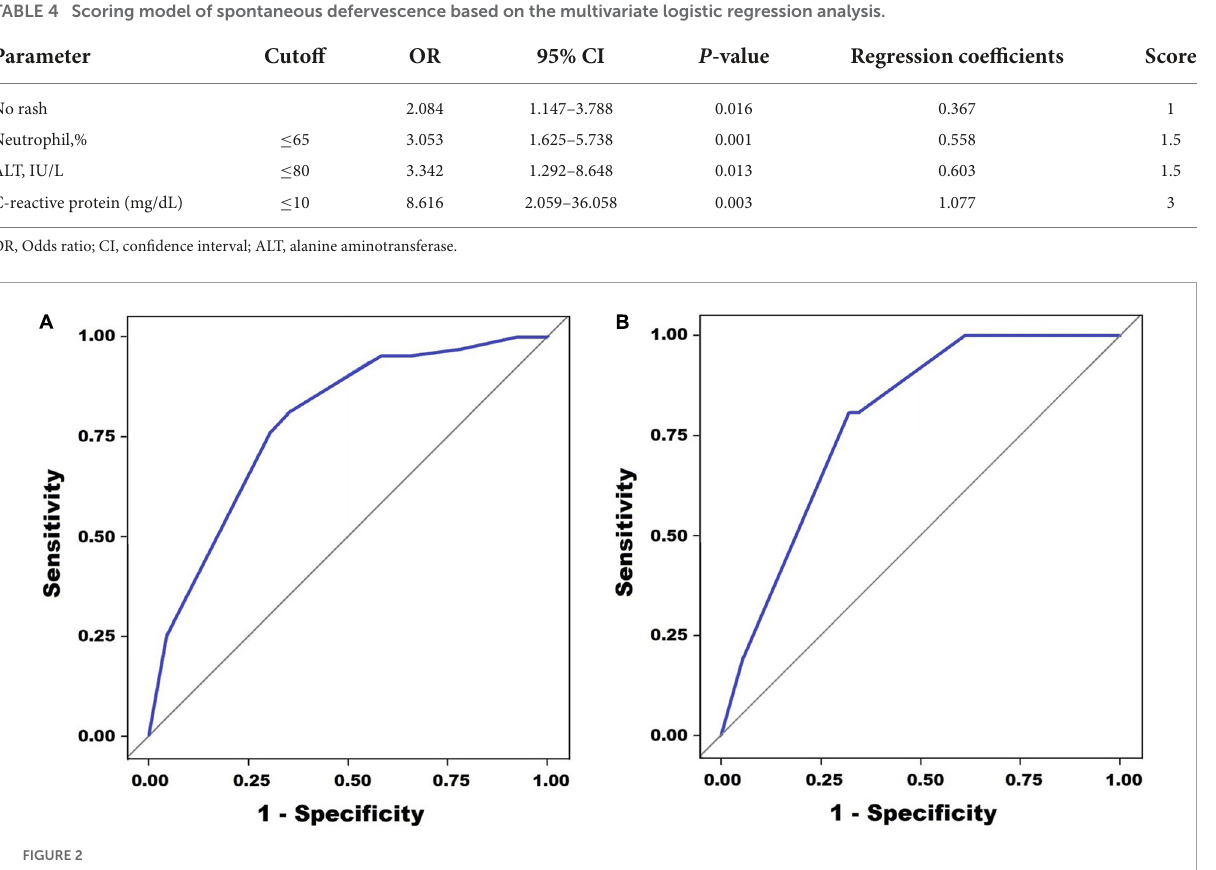
TABLE 4 Scoring model of spontaneous defervescence based on the multivariate logistic regression analysis.